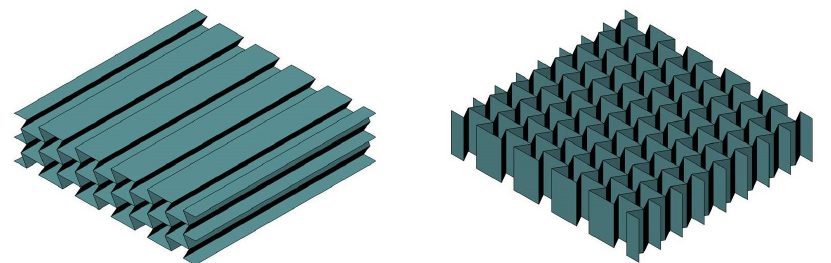
Figure 1. Examples of prismatic core structures based on the standard auxetic topology. ( Left ) open-cell core. ( Right ) closed-cell core.